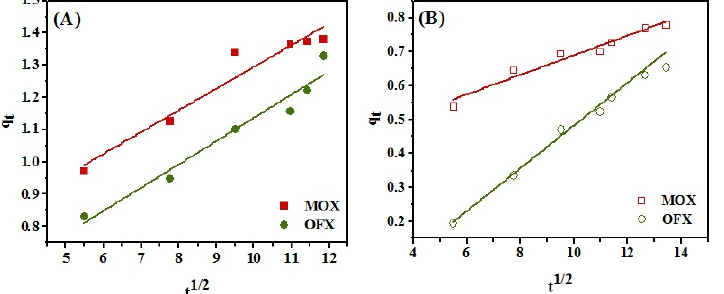
Figure 13. Intraparticle diffusion models for MOX and OFX adsorption onto ( A ) functionalized (Met-GO/SA) ( B ) non-functionalized (GO/SA) adsorbent. (Met-GO/SA) ( B ) non-functionalized (GO/SA)